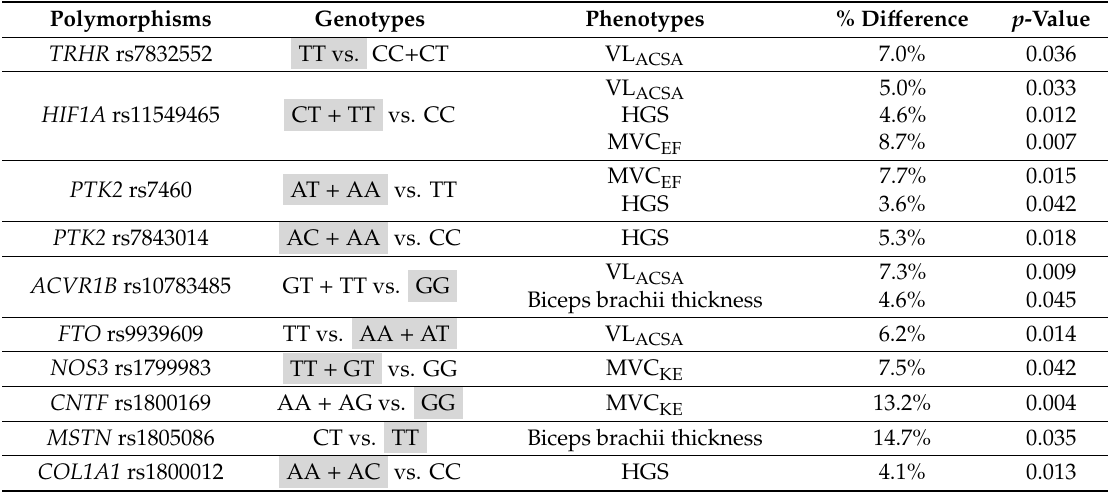
Grey shadings denote the favourable groups for skeletal muscle phenotypes. Abbreviations: HGS—handgrip strength, VL ACSA —vastus lateralis anatomical cross-sectional area, MVC KE —isometric knee extension torque maximal voluntary contraction, MVC EF —isometric elbow flexion torque maximal voluntary